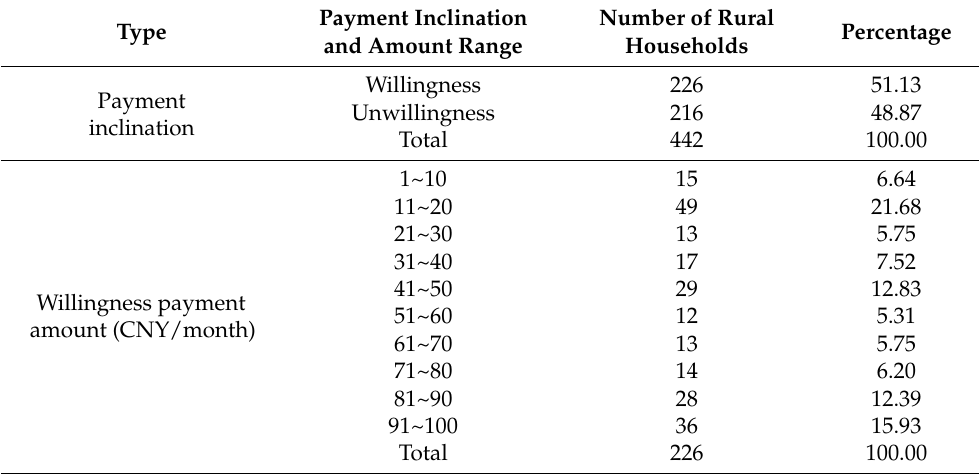
Table 5. The distribution of rural households’ WTP for